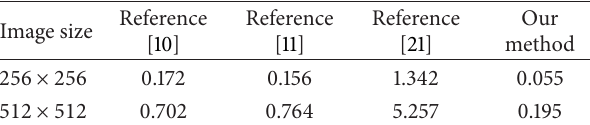
Table 1: Correlation coefficients.